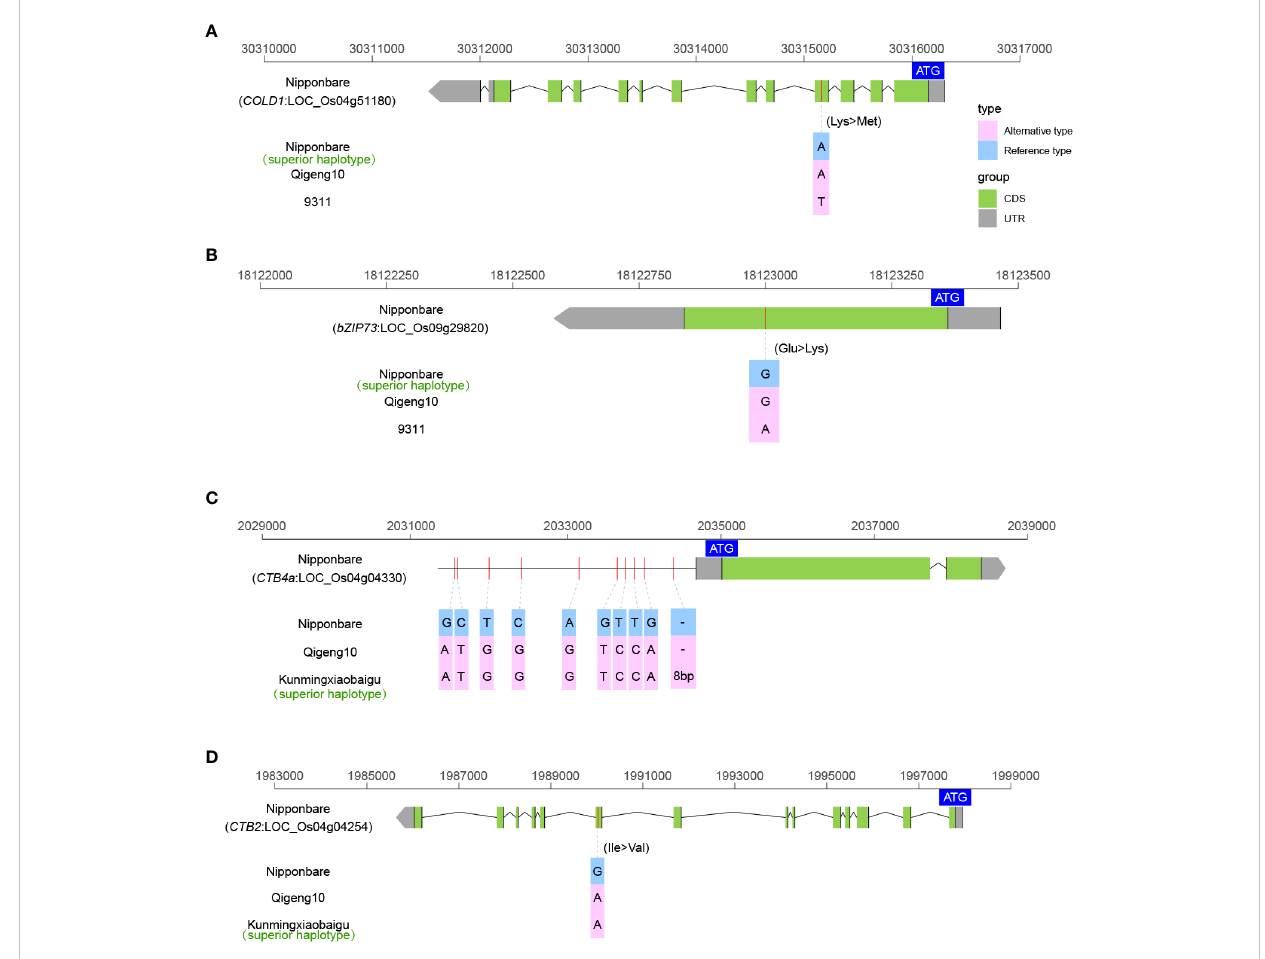
FIGURE 4 The allelic information of sequence variants in COLD1 (A) , bZIP73 (B) , CTB4a (C) , and CTB2 (D) controlling cold tolerance in